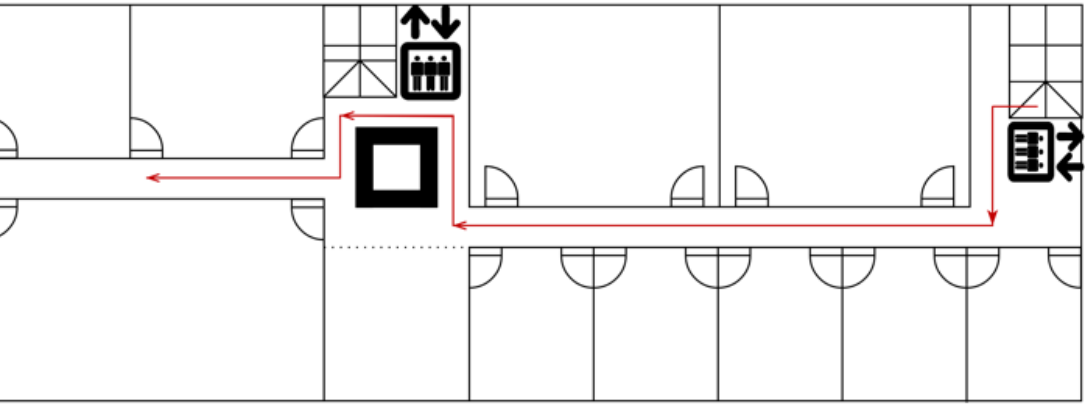
Figure 3. The floor plan of our experiment.